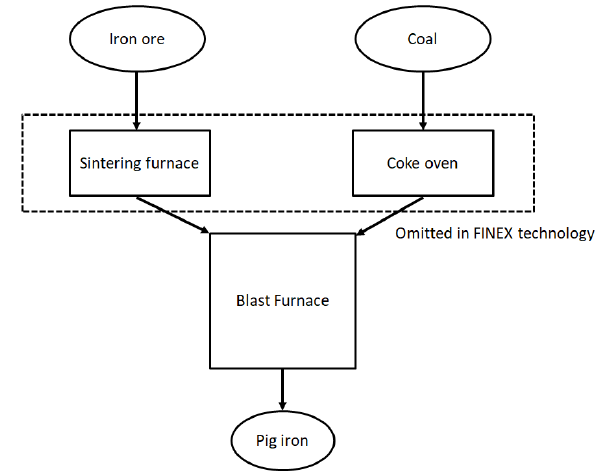
Figure 1. Process comparison between